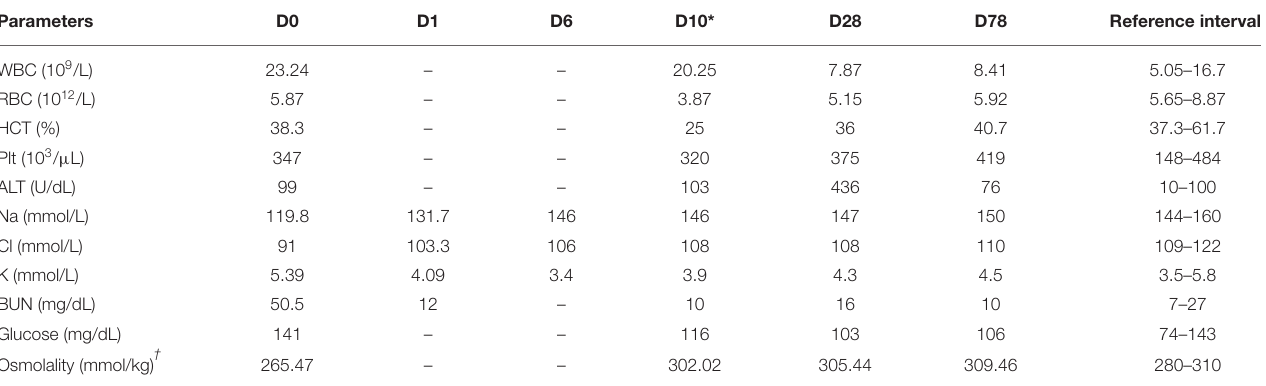
TABLE 1 | Complete blood count, serum biochemistry, and serum electrolytes results in a dog with primary hypoadrenocorticism and osmotic demyelination syndrome.